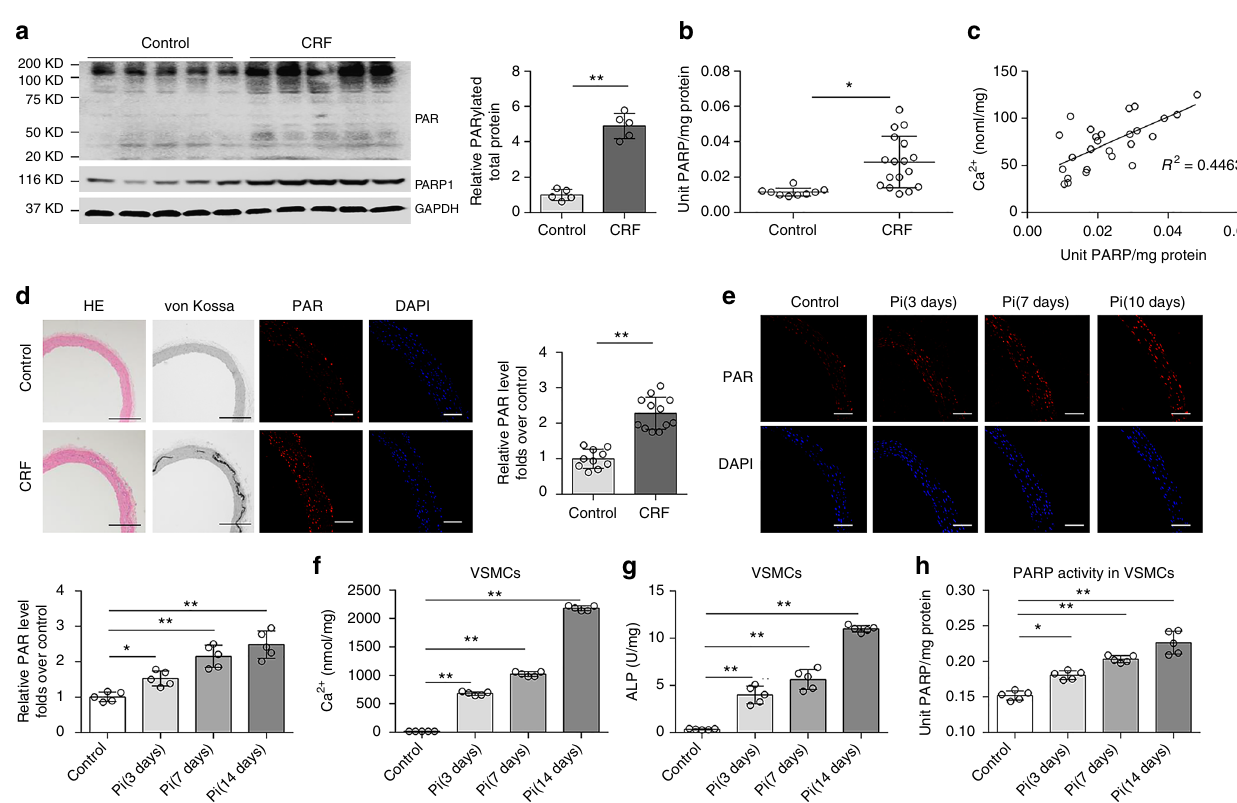
Fig. 1 PARP activity is increased in calcifying arteries and VSMCs. a Representative western blot analysis of PARP1 expression and PARP activity (Poly (ADP-ribosyl)ation) in radial arteries. Chronic renal failure (CRF): patients with CRF and uremia who underwent arterial venous fi stular surgery ( n = 5); Control ( n = 5): patients who underwent amputation surgery due to arm trauma, without diagnosed complications of diabetes and chronic kidney disease. b PARP activity in radial arteries of control ( n = 9) and CRF patients ( n = 17) were assayed using the universal colorimetric PARP assay kit. c The calcium content and PARP activity were positively correlated in CRF arteries. R 2 = 0.4463, P < 0.05. Statistical signi fi cance of correlations was determined by Pearson ’ s correlation coef fi cient analysis. d Wistar rats were fed an adenine diet or a chow diet for 6 weeks ( n = 10 – 12 per group). Arteries were isolated and performed by hematoxylin/eosin (H&E) and von Kossa staining. The PAR level was determined by immuno fl uorescence staining. Scale bars: black, 200 μ m; white, 100 μ m. e Rat aortic rings were treated with high Pi (osteogenic medium containing 10 mM β -glycerophosphate) for indicated days (0, 3, 7, and 10 days), and PARP activity was then detected by immuno fl uorescence staining. ( n = 5 per group). Scale bar, 100 μ m. f – h Rat VSMCs were treated with high Pi (10 mM β -glycerophosphate) for indicated days (0, 3, 7, and 14 days). The calcium content ( f ), ALP activity ( g ), and PARP activity ( h ) in calci fi ed VSMCs were assayed. ( n = 5 per group). Statistical signi fi cance was assessed using one-way ANOVA for multiple comparison and two-tailed t -tests for two groups and is presented as follows: * P < 0.05 and ** P < 0.01. All values are means ± S.D.